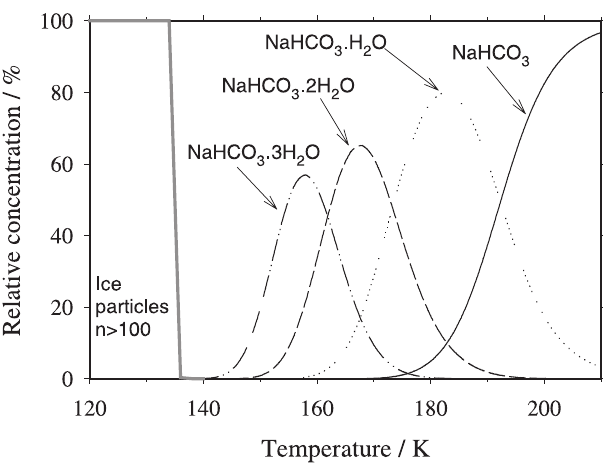
Fig. 5. Equilibrium populations of NaHCO NaHCO (H O) clusters ( n = 1, 2, 3 and >100), as a function of 3 2 n temperature. The H O mixing ratio is constant at 2